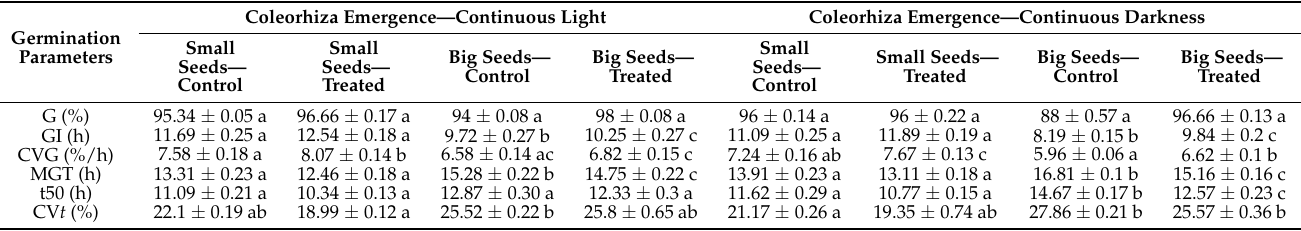
Table 3. EMF effects on germination parameters for coleorhiza emergence during germination of small and big seeds of winter wheat, in control conditions, and after EMF treatment.